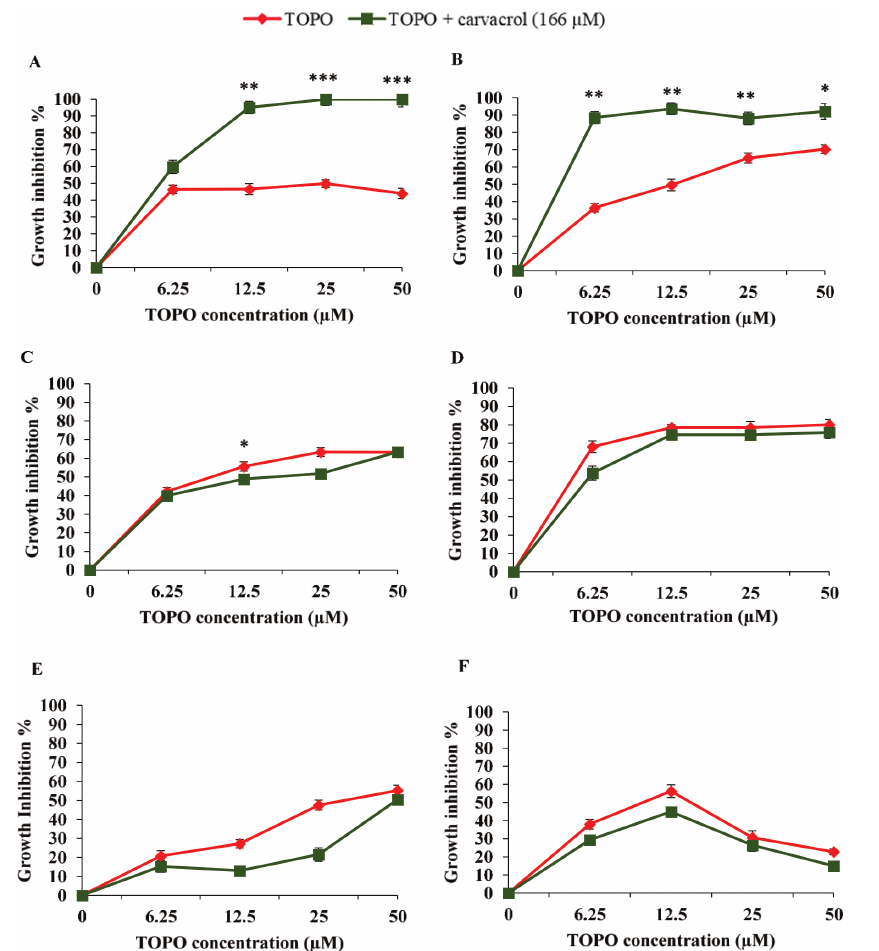
Figure 1. The curves of the growth inhibition percentages after 24 h treatment with different concentrations of TOPO in the absence or presence of a fixed concentration of carvacrol (166 µM)) in (A) HeLa, (B) HCT116, (C) MCF-7, (D) HepG2, (E) SKOV3 and (F) A549 cell lines. Data were expressed as mean ± SD (error bars), n = 3. The significant differences between TOPO and (TOPO + carvacrol (166 µM)) combination at each time assessed by mesuring the P -values using the independent t -test, were classified to * P < 0.05, ** P < 0.01 and *** P <